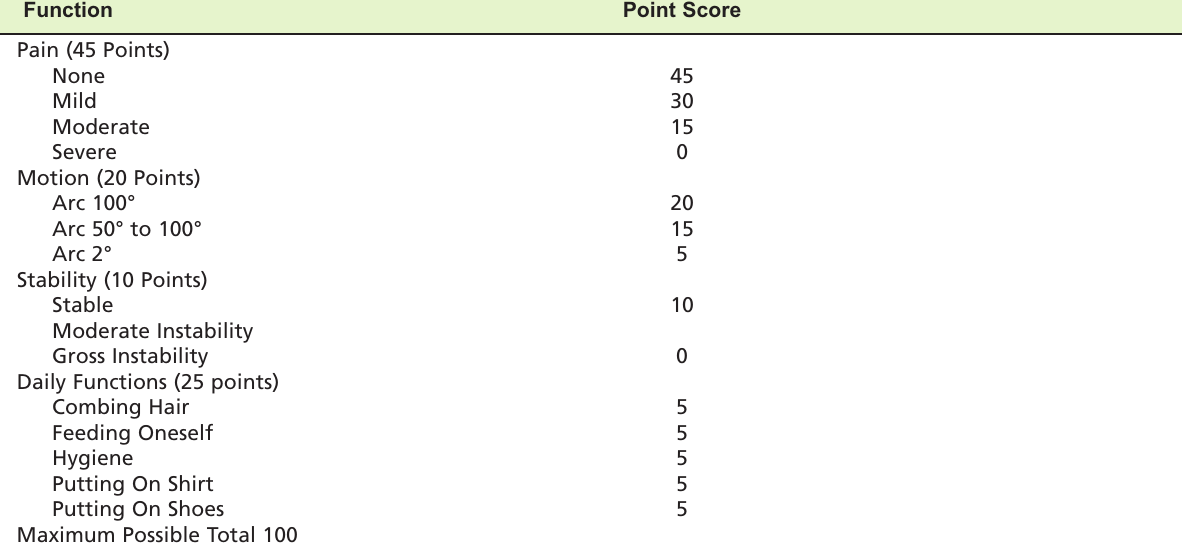
Mayo elbow performance score Table I: